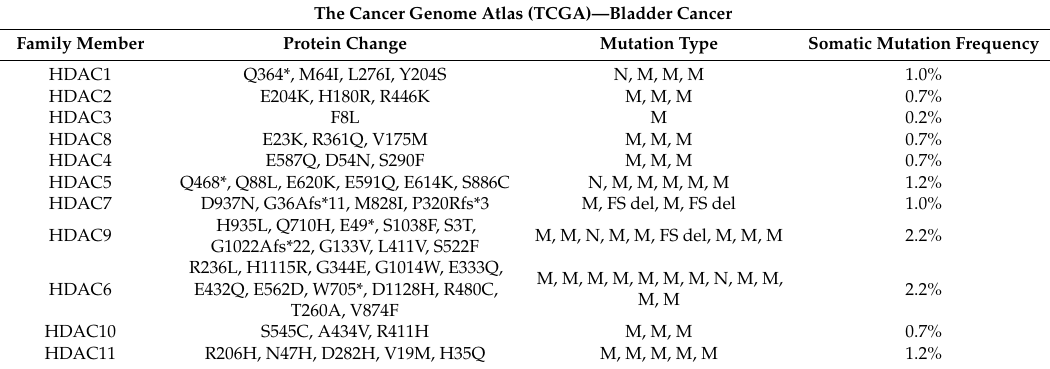
Table 1. Collection of mutations detected in the 18 HDAC family members, using a cohort of 412 patients being affected by bladder cancer (MIBC). All data were provided by the TCGA consortium